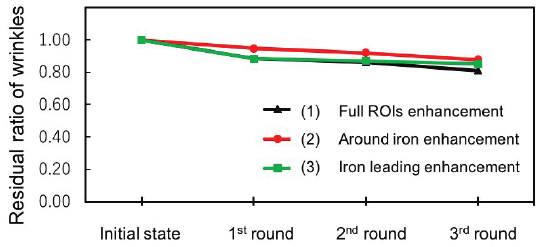
Figure 5. Change in wrinkle residual ratio by trials (averages of 8 subjects)